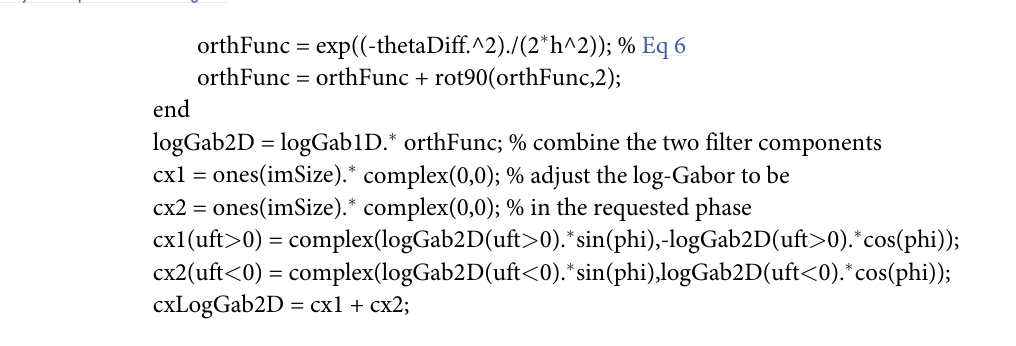
Fig 8. Maximum orientation bandwidth as a function of spatial frequency bandwidth ( ω ). The straight dashed line is given by 15log 2 ( ω ) + 45.